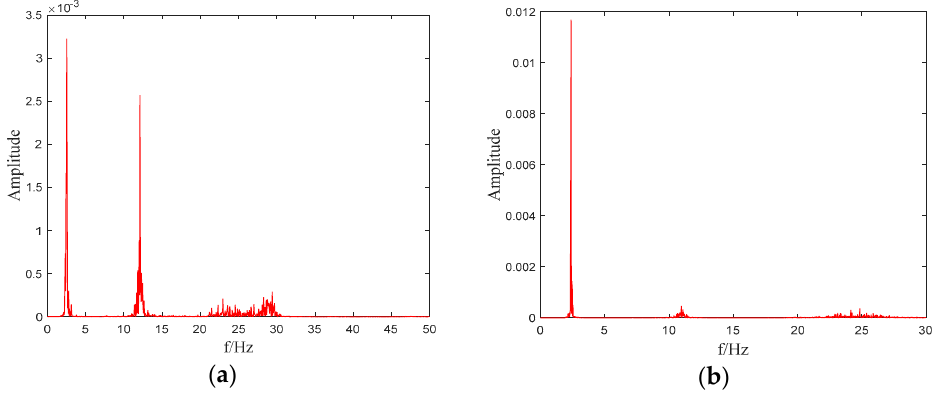
Figure 9. PSD figures for acceleration outputs of the top floor: ( a ) Before the earthquake excitations; ( b ) After the earthquake excitations.